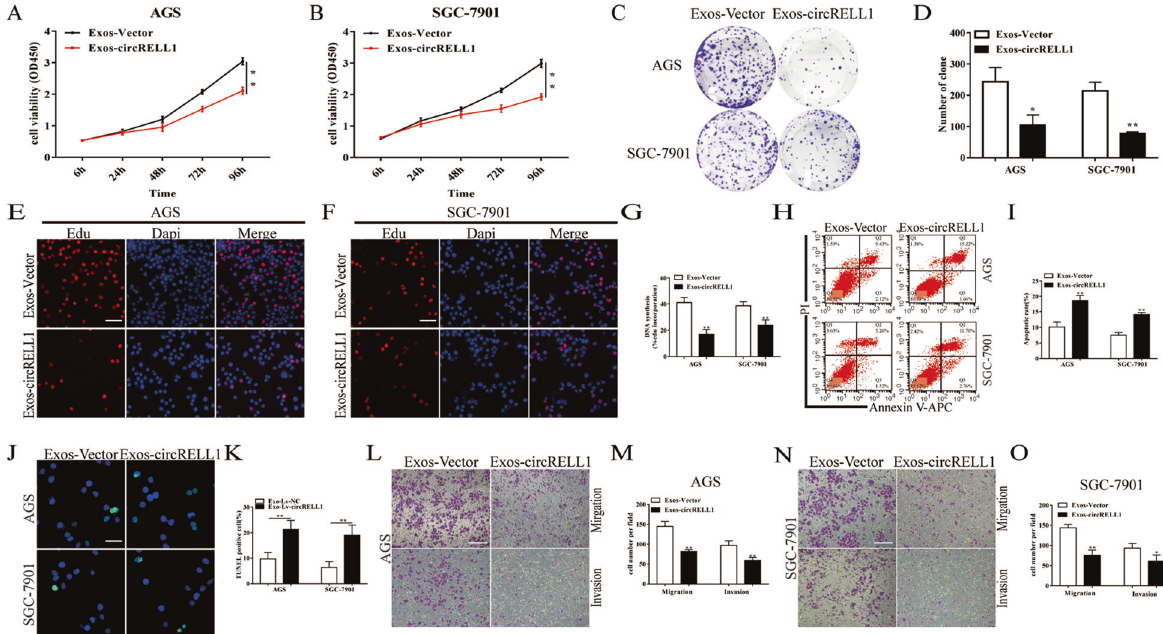
Fig. 3 Intercellular transfer of exosomal circRELL1 suppresses the malignant phenotype in vitro. A , B CCK-8 assay was utilized to measure cell viability in GC cells after co-culturation with exos-circRELL1 or exos-vector derived from GC cells medium. C , D Colony formation assays were applied to measure cell proliferation ability in GC cells. E – G Edu assays were used to explore cell proliferation capability in GC cells (scale bar: 100 μ m). H – K Flow cytometry assays and TUNEL assays were conducted to access cell apoptosis rates in GC cells (scale bar: 100 μ